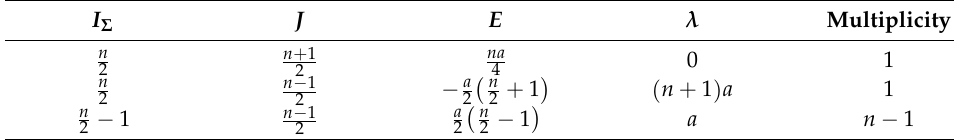
Table 1. Energies E and corresponding roots λ for subspace K = K max −